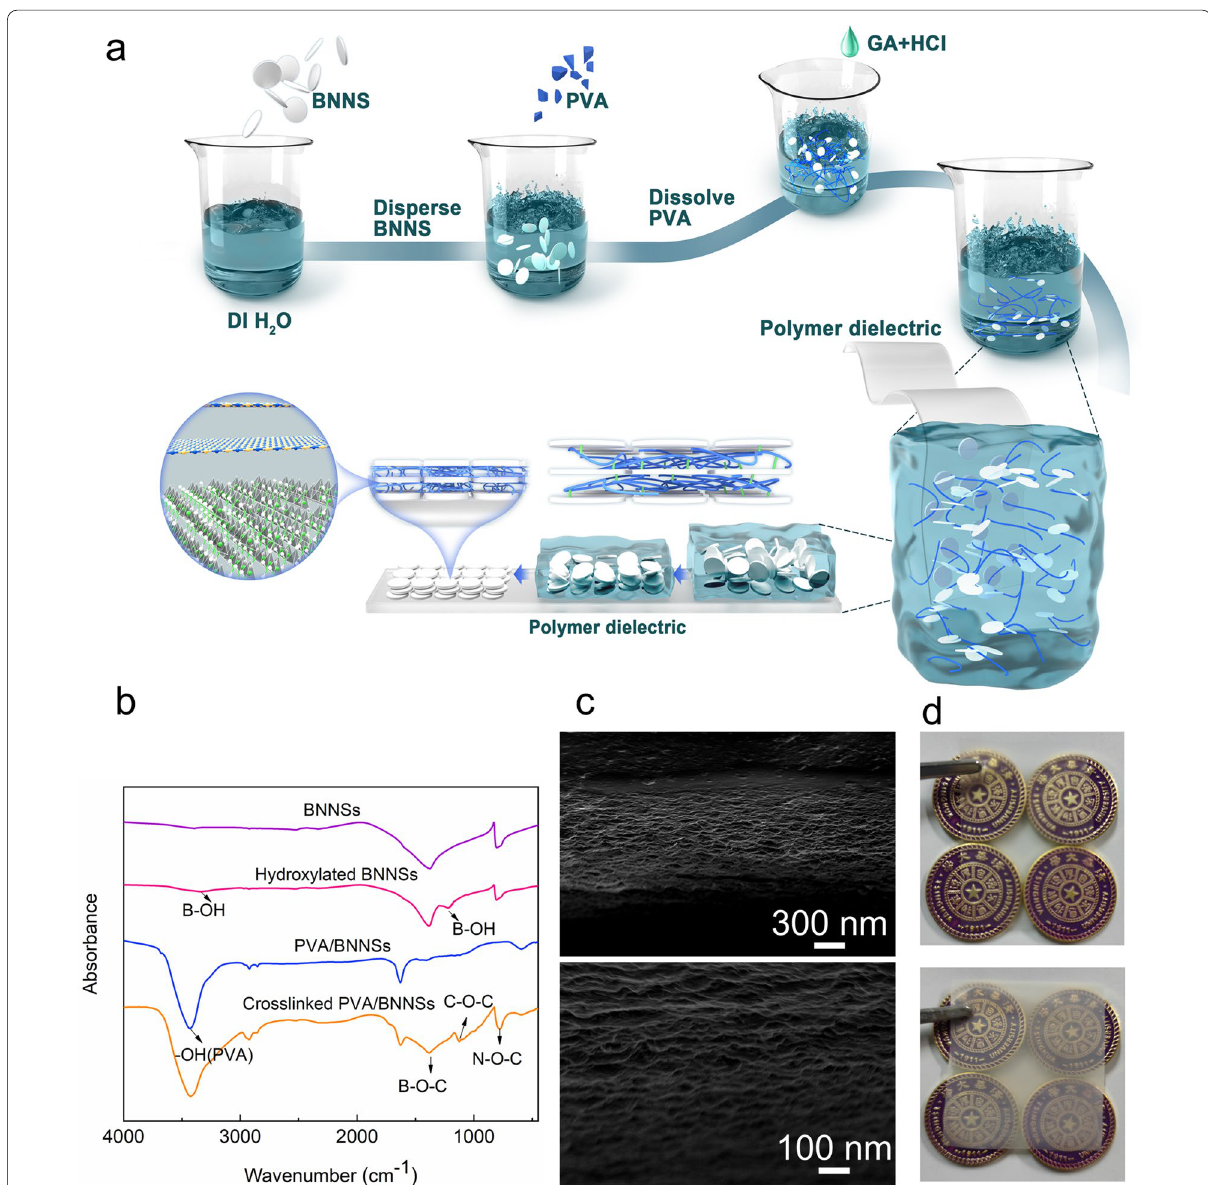
Fig. 1 Sample preparation process and characterization. a Schematic diagram of the coating preparation process. b FTIR spectra of BNNSs before and after hydroxylation and before and after the PVA/BNNS cross‑linking reaction. c SEM images of the cross section of the coating. d Photographs of the BOPP film before and after coating (top, uncoated; bottom,